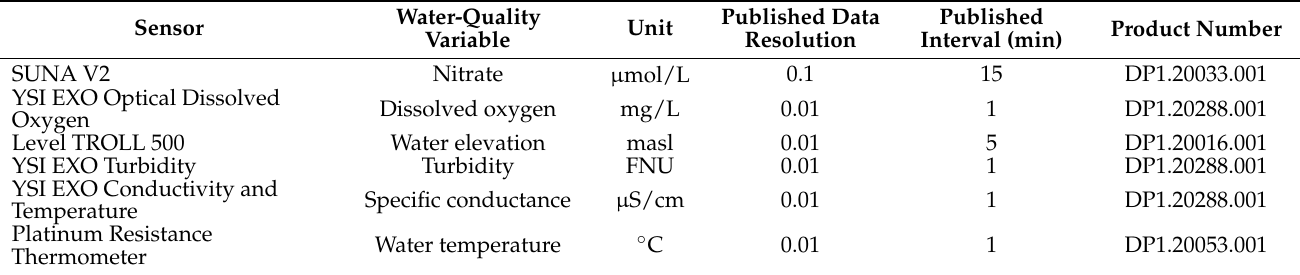
Table 1. NEON data. Details on sensors, variables collected, units of measurement, associated data collection intervals, and the NEON data product number for data used in this